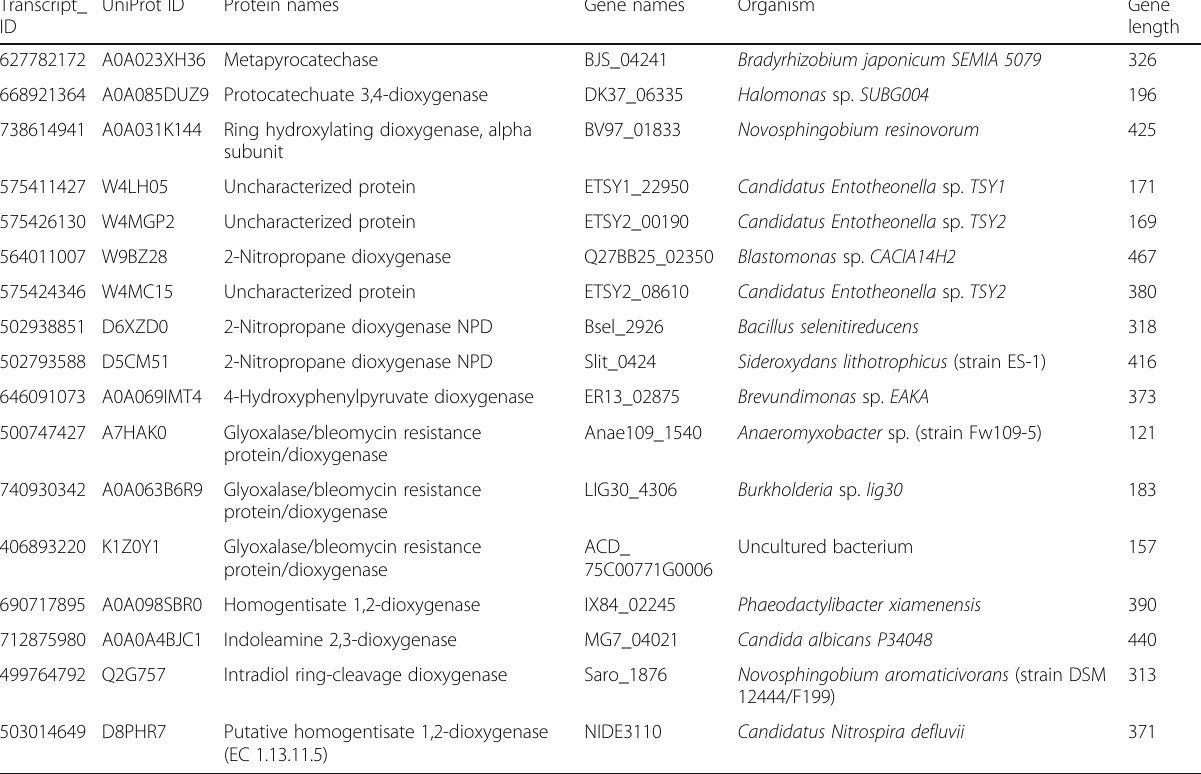
Table 3 Transcripts showing high expression related to aromatic hydrocarbon degradation in M1 compared to O1 ( p value ≤